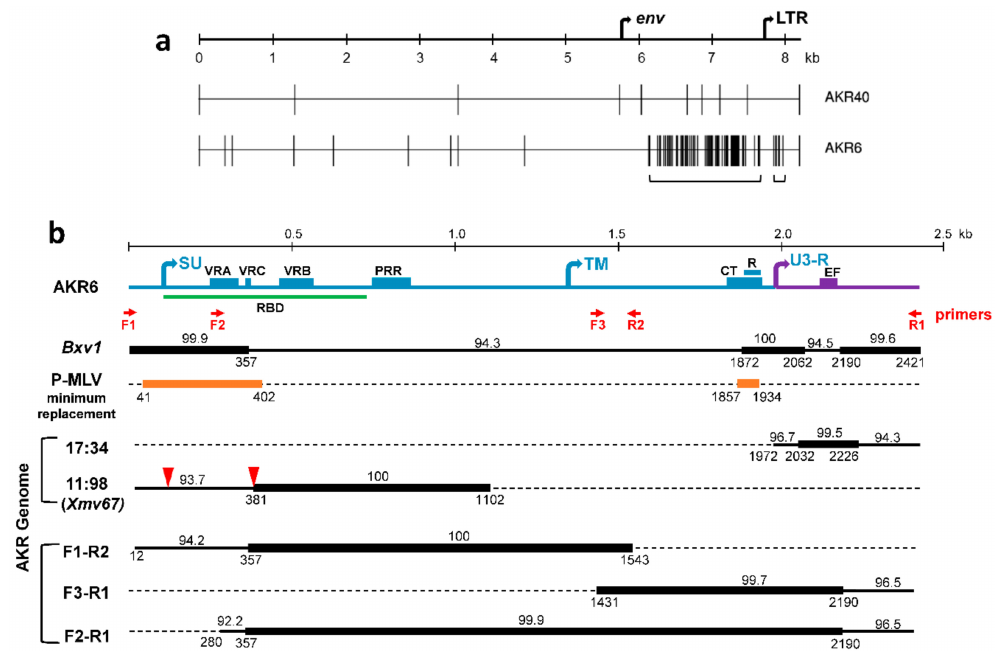
Figure 1. Comparative analysis of AKR6 and AKR40 X-MLVs. ( a ) Highlighter plots use vertical lines to identify nucleotide mismatches relative to the Bxv1 Xmv . Brackets indicate two substituted segments in AKR6 relative to Bxv1 . ( b ) Sequence relationships between AKR6 and related endogenous retroviruses (ERVs) and PCR-amplified segments from AKR mice. The env -U3-R segment of the viral genome diagramed at the top notes the locations of the three variable domains (VRA, VRB, and VRC), the proline rich region (PRR) and the receptor binding domain (RBD) within the surface (SU) domain of Env, the cytoplasmic tail (CT) and R-peptide (R) in the transmembrane (TM) domain, and the enhancer framework (EF) within U3. Six black lines show segmental sequence comparisons to AKR6 for Bxv1 and 5 AKR-derived AKR6-related sequences, two from the AKR genome representing a solo long terminal repeat (LTR) and a partial env with two duplications associated with sequencing gaps (red triangles), and three PCR products from AKR amplified using the indicated primers (in red). The orange line positions the two replacements common to the P-MLVs. The numbers above each line show % identity to AKR6, and the numbers below the line identify the start and stop positions of each segment relative to AKR6. Identity > 99% is shown with a thick